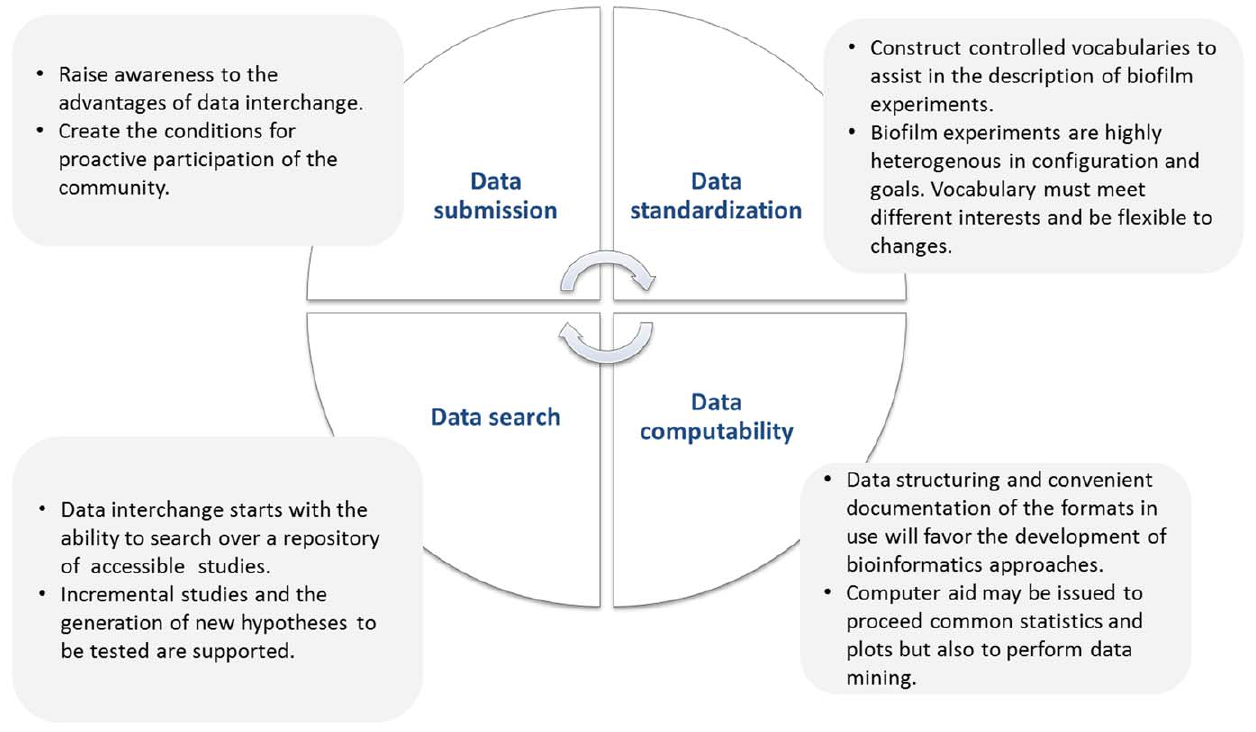
Figure 2. Main requirements to the development and implementation of biofilm-centered bioinformatics.